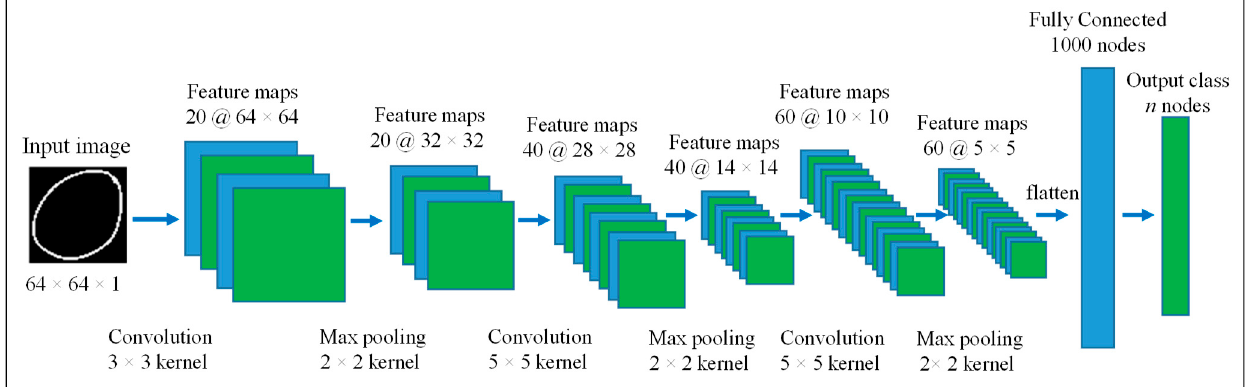
Figure 11. The convolutional neural network (CNN) architecture used in the proposed system.